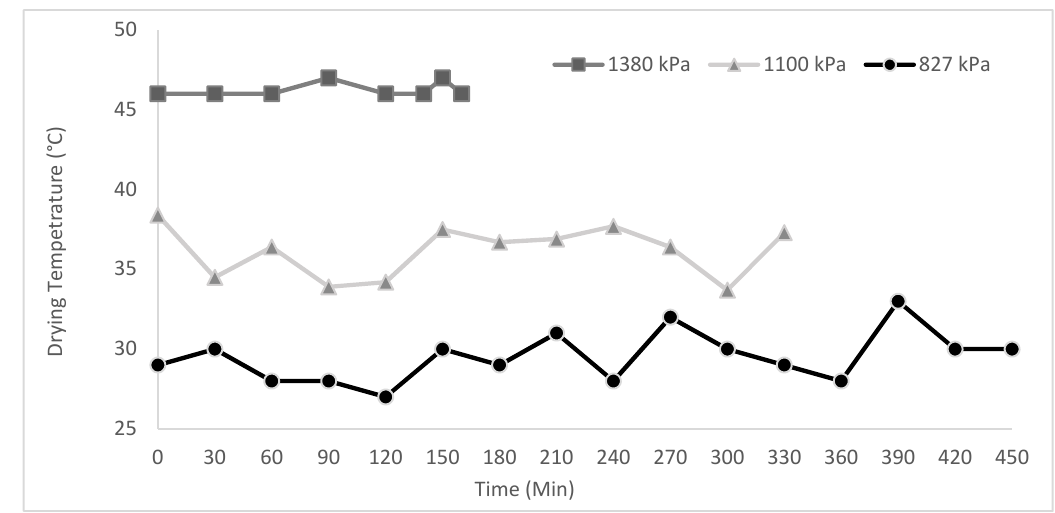
Figure 5. Drying temperature profile for different compressor discharge pressure.